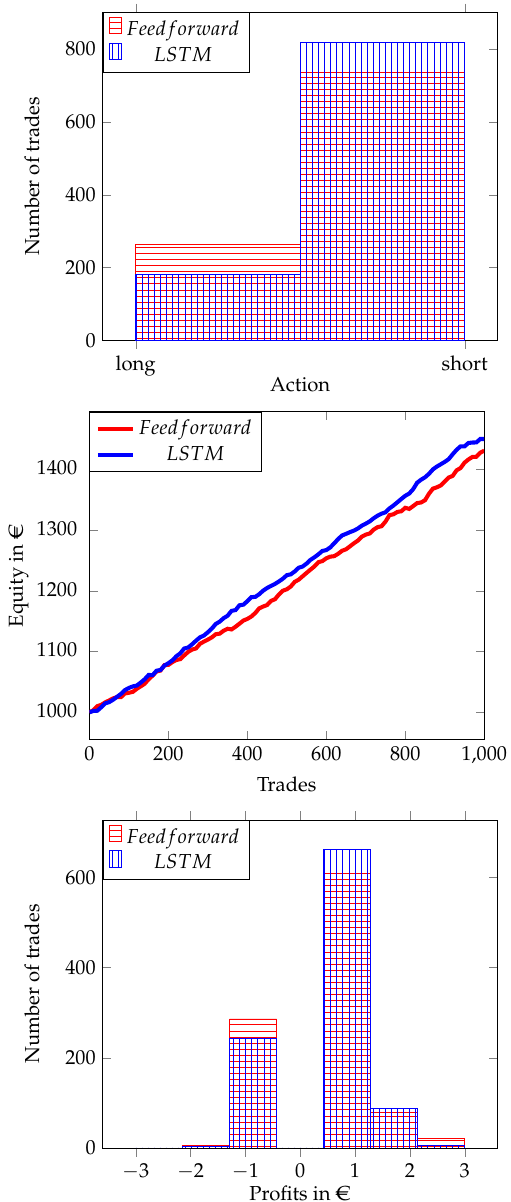
Figure 3. Test results. Top: action distribution. Mid: equity development. Bottom: profit distribution.